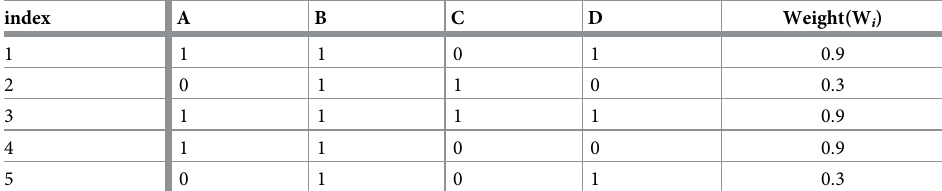
Table 1. Sample data from example Bayesian